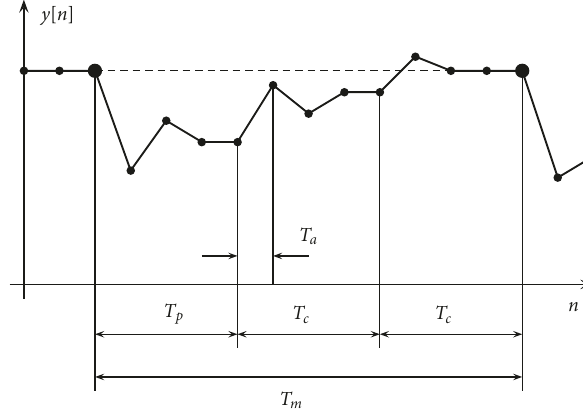
Figure 2: Times involved in the adaptation and control